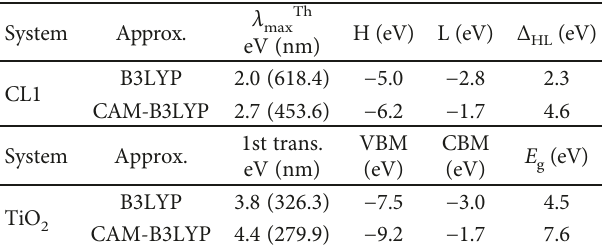
− E = E ). For titania, we HL LUMO HOMO ). g